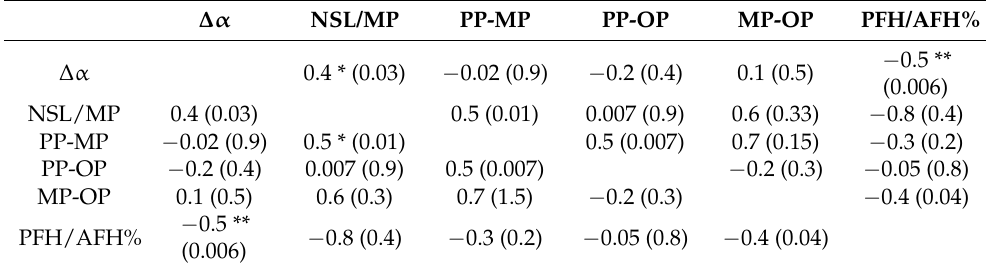
Table 4. Pearson’s correlation